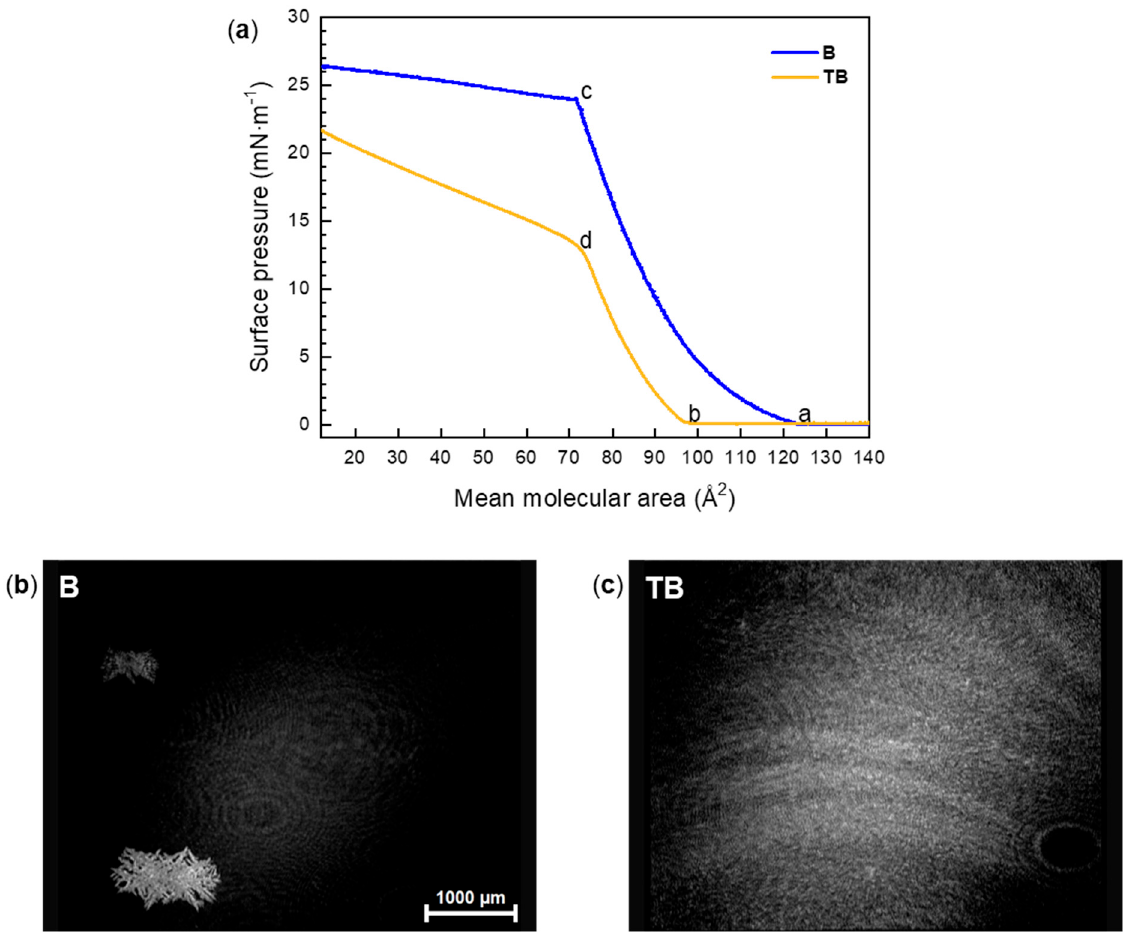
Figure 4. ( a ) π -mmA isotherm recorded on the water subphase at 20 °C with the compression rate of 1.5 Å 2 / (molecule ‧ min); Table 124 Å 2 , b = ~ 97 Å 2 , c= ~ 71 Å 2 , and d = ~ 73 Å 2 . ( b , c ) BAM images of the Langmuir films at 15 Å 2 of model compounds B and TB .